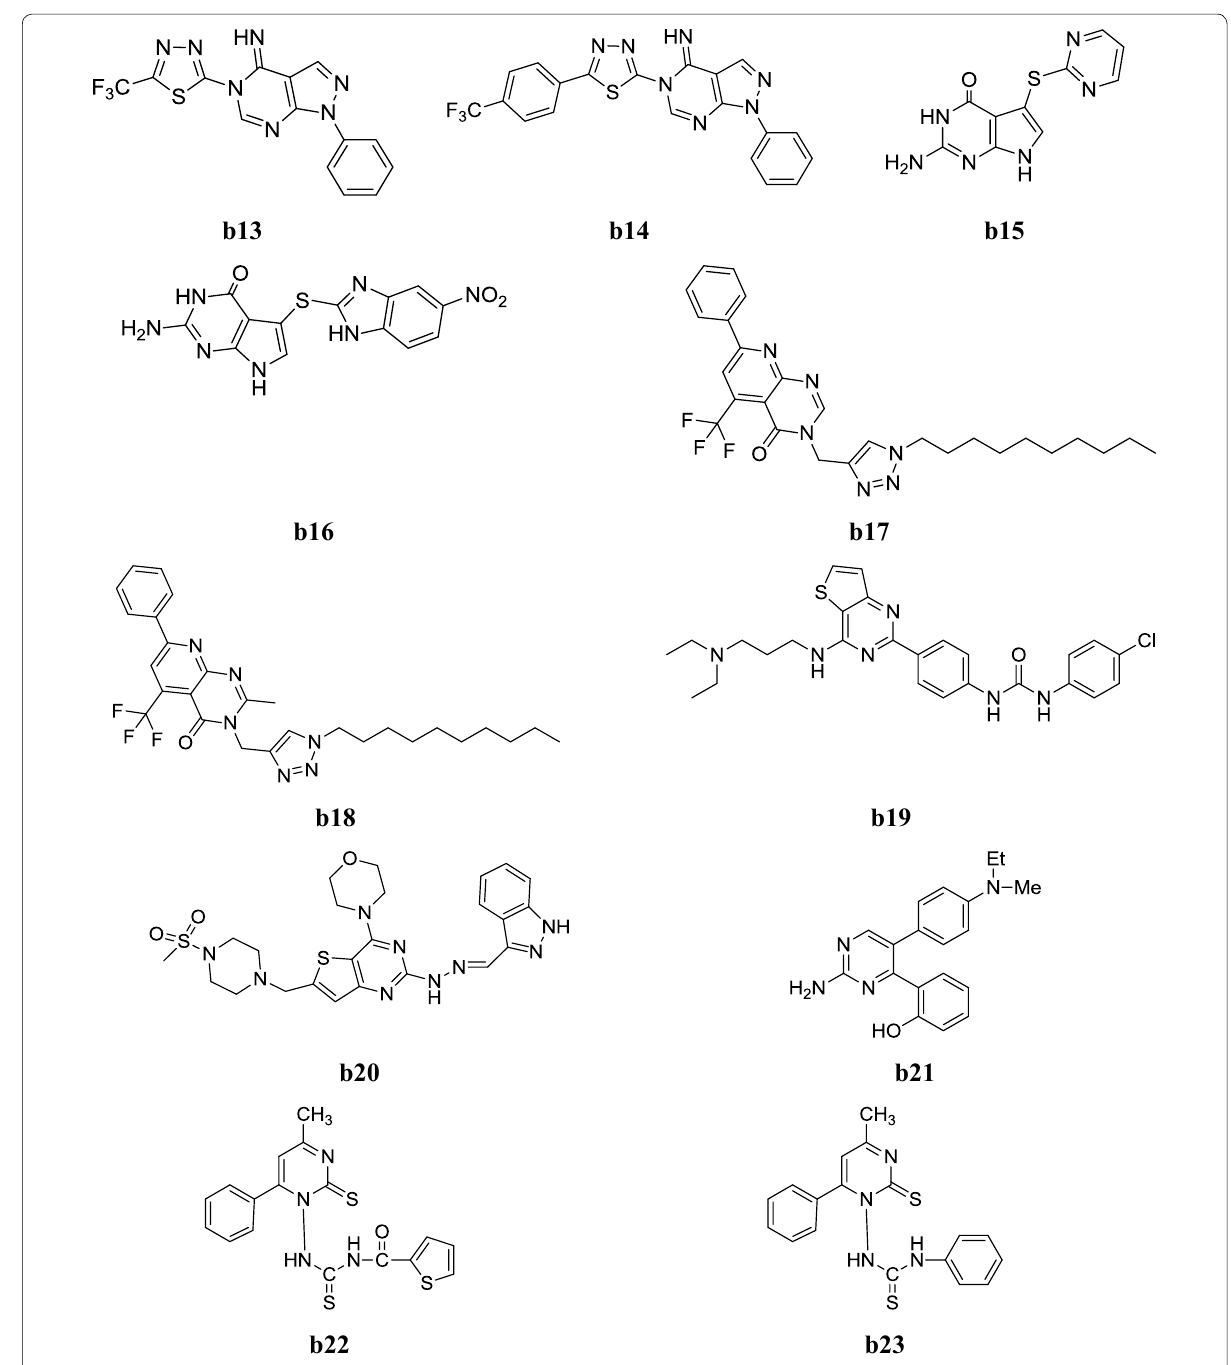
Fig. 6 Chemical structures of the most active anticancer pyrimidine derivatives ( b13 – b23